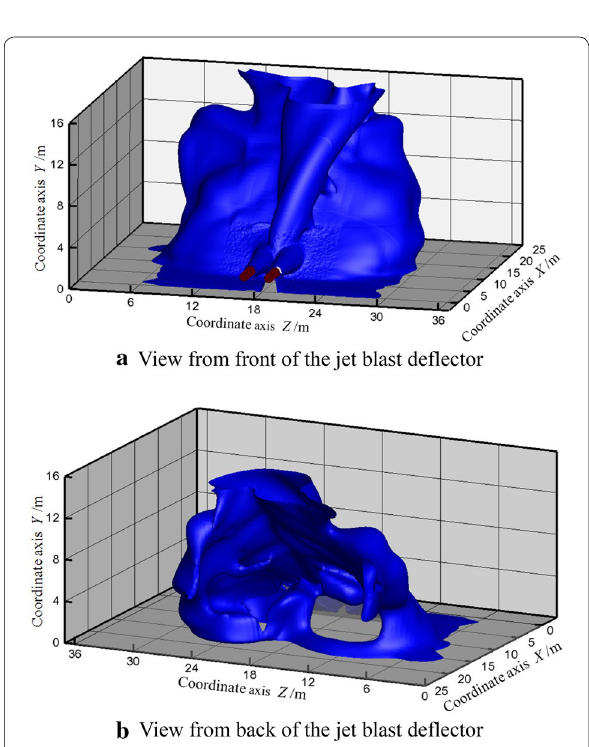
Figure 22 Velocity contour of 20.8 m/s in computational domain